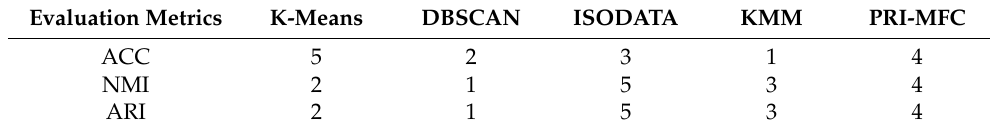
Table 8. The weight values of the weighted averages of the evaluation index of five algorithms.